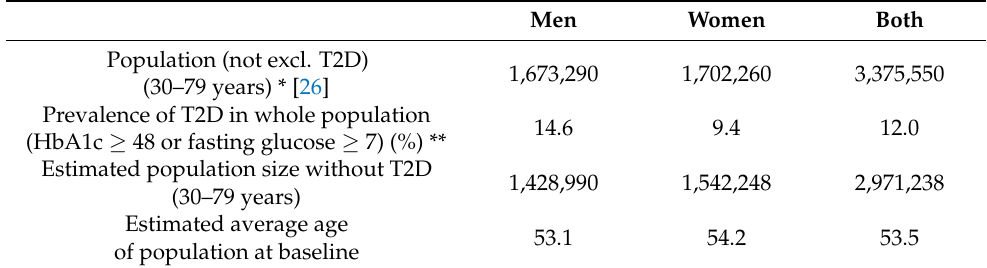
Table 1. Baseline characteristics of the cohorts used to define the size of the target cohort and its underlying risk of T2D in the Markov model. See Supplementary Table S1 for further